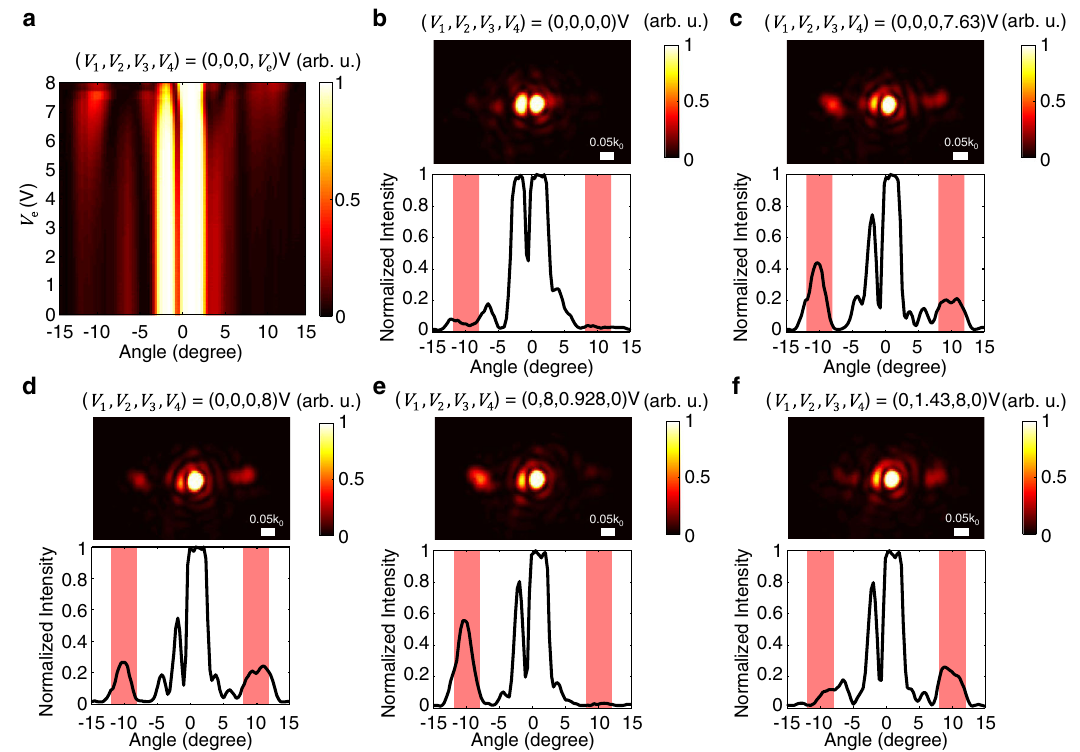
Fig. 4 | Tunable diffraction with the asymmetric nano-electromechanical metasurface. a Measured intensity at the Fourier plane of the metasurface as a functionoftheappliedbiasfrom0Vto8V( λ =1524nm).Ateachbias,theintensity is normalized by the peak intensity near 0 ∘ . The ±1st order diffractions start to appear ~±10 ∘ when the applied bias is over 6V. On top of the image, the values of V 1 – V 4 are noted and only V 4 is changed. b – f Measured diffraction patterns for